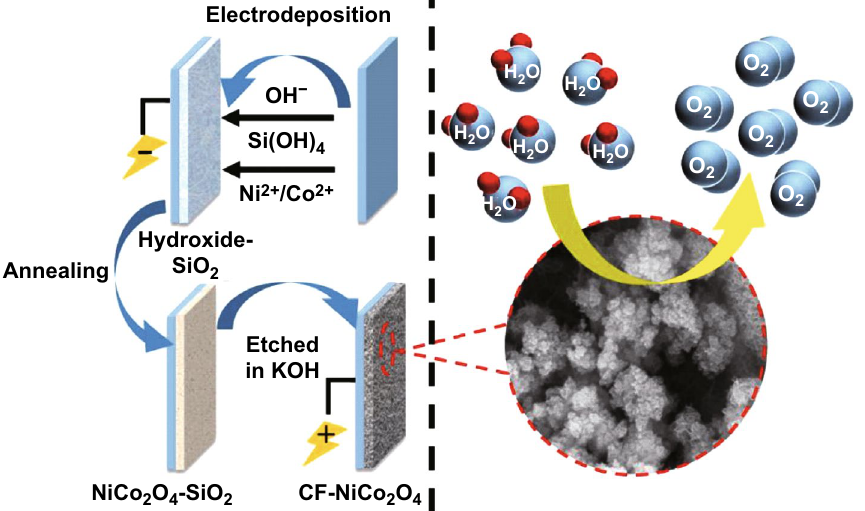
Fig. 16 Schematic illustration of the formation of cauliflower-like NiCo 2 O 4 film. Reproduced with permission from Ref. [165]. Copyright © 2017 Hydrogen Energy Publications LLC. Published by Elsevier